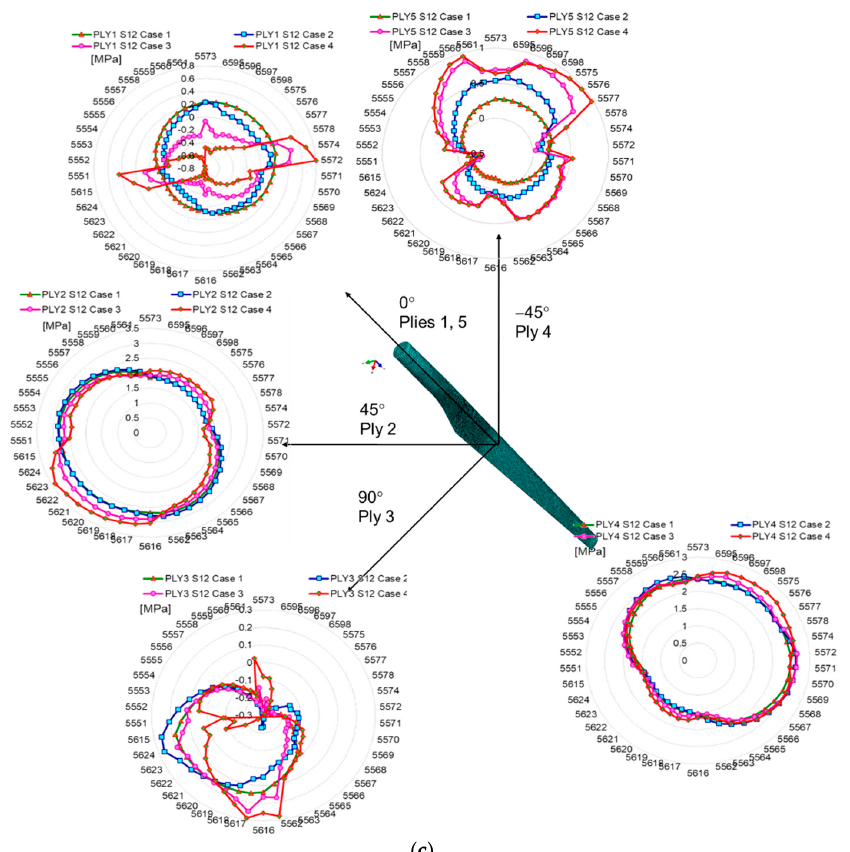
Figure 7. Variation of stresses in relation to the composite layer orientation, extracted from area 2: ( a ) S11 stress; ( b ) S22; ( c ) S12.